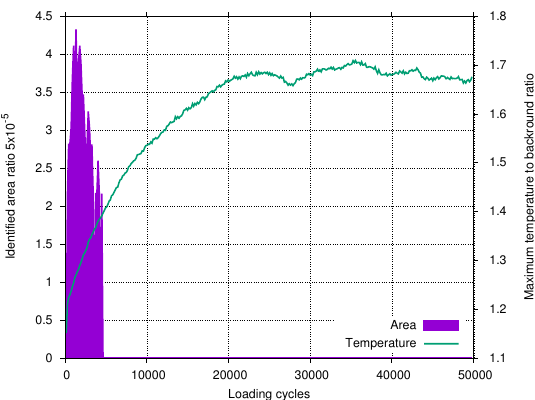
Figure 8. Evolution of identified heated area dur- ing mean temperature of specimen during 5 ± 4 . 5 kN